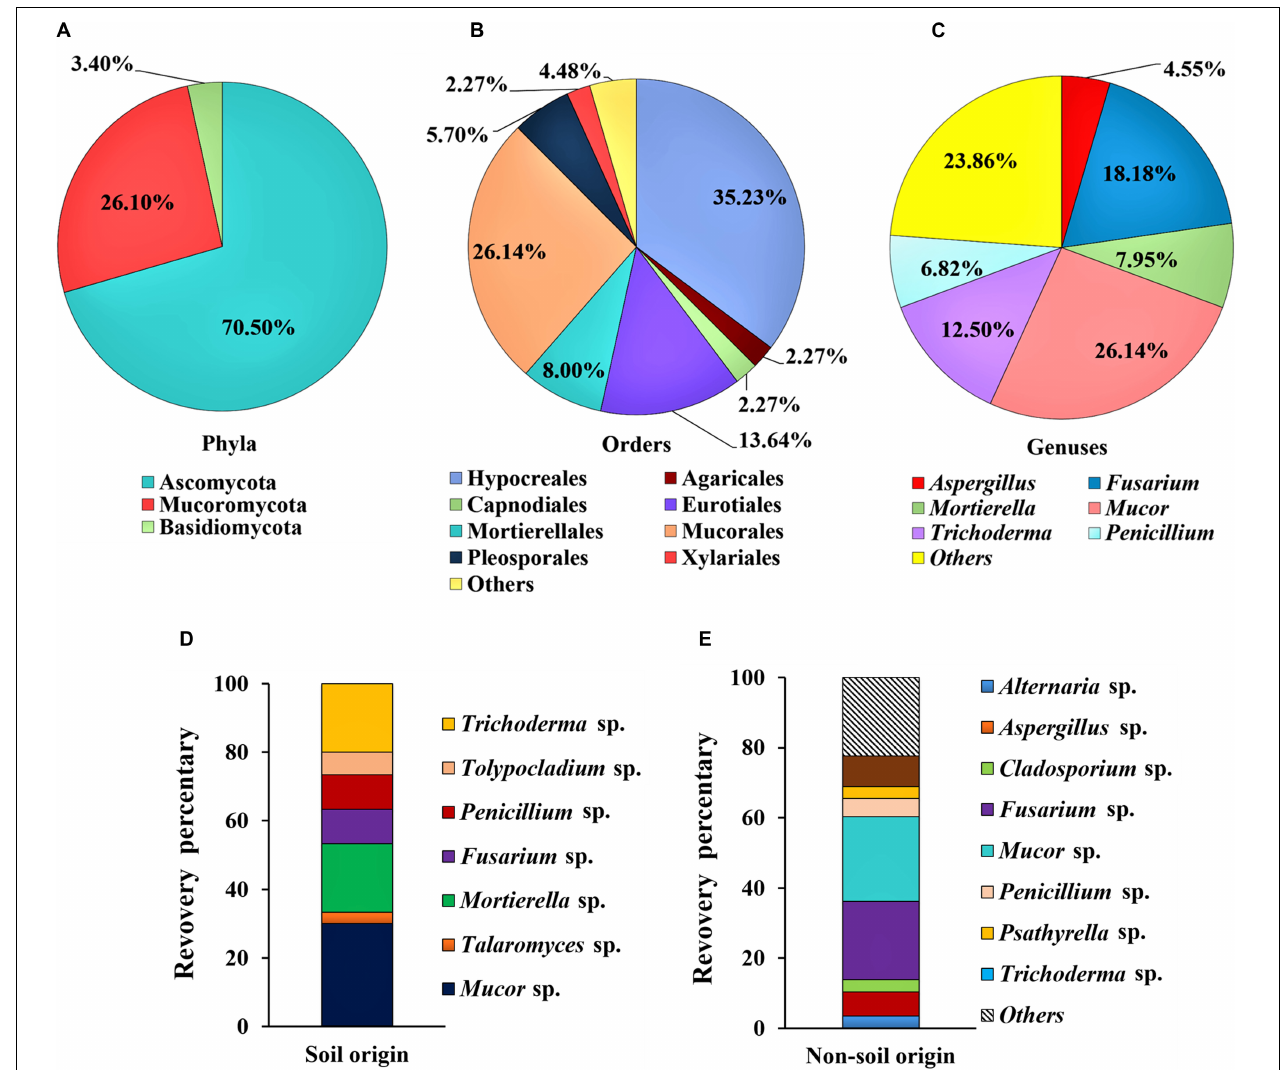
FIGURE 1 | Composition of the dominant filamentous fungal strains isolated from Tibet. The classification was shown at the phyla level (A) ; order level (B) ; and genus level (C) ; and comparison on the diversity of the fungal strains between the soil (D) and the non-soil (E) samples.